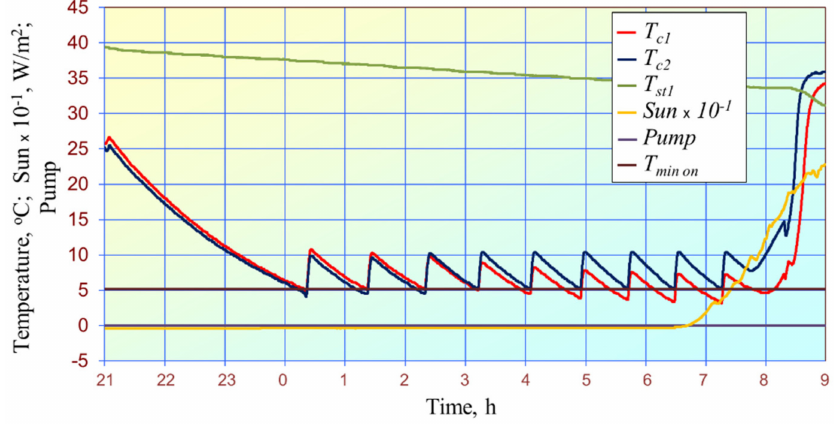
Figure 18. Nighttime control for the solenoid valve (5 April 2021).